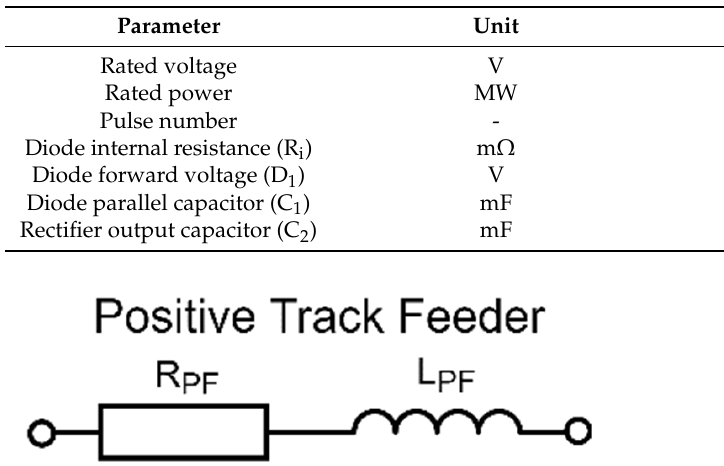
Table 3. Rectifier input parameters [24].